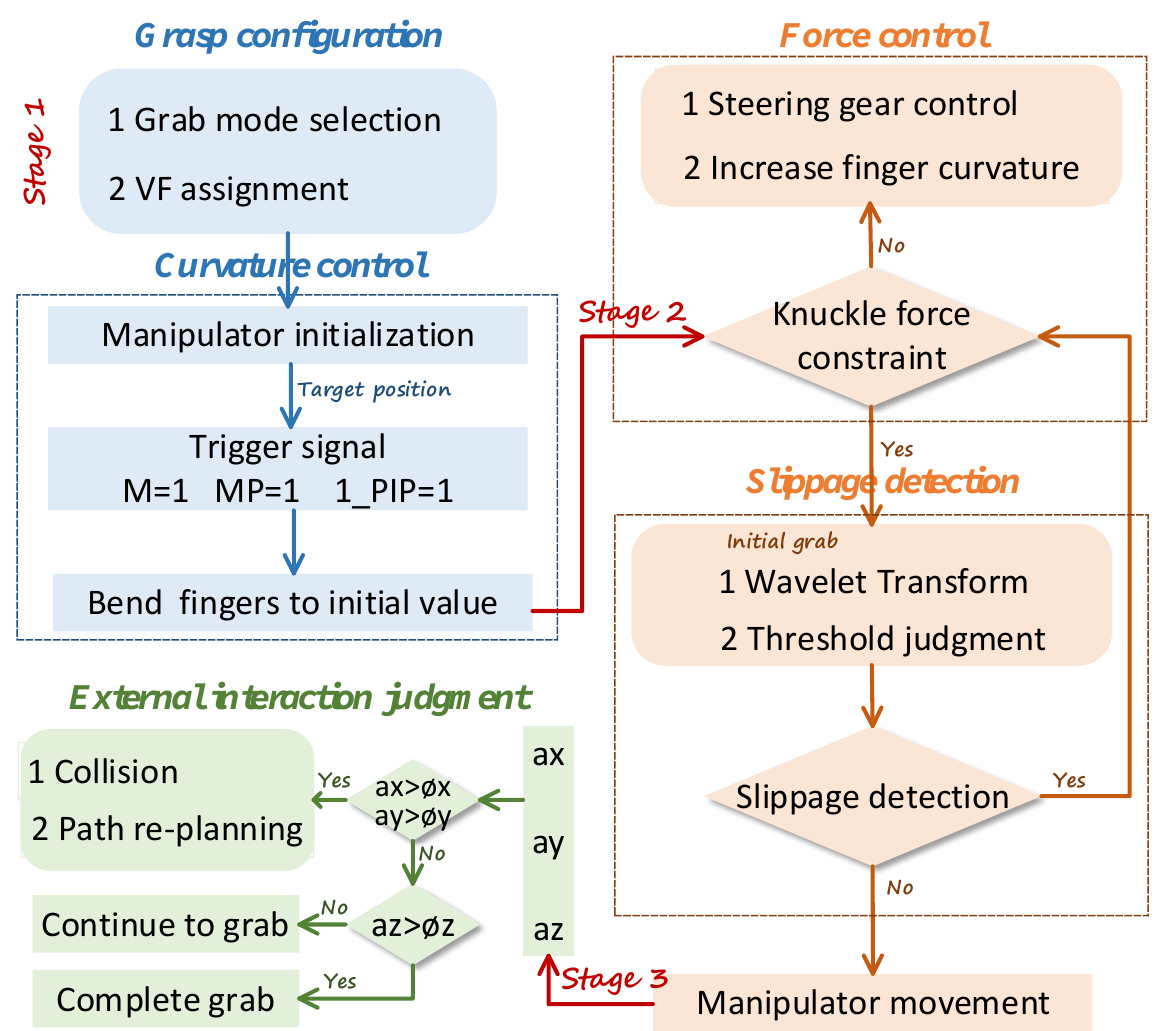
Figure 13. Grasp planning flow chart of manipulator based on manual grasp mechanism